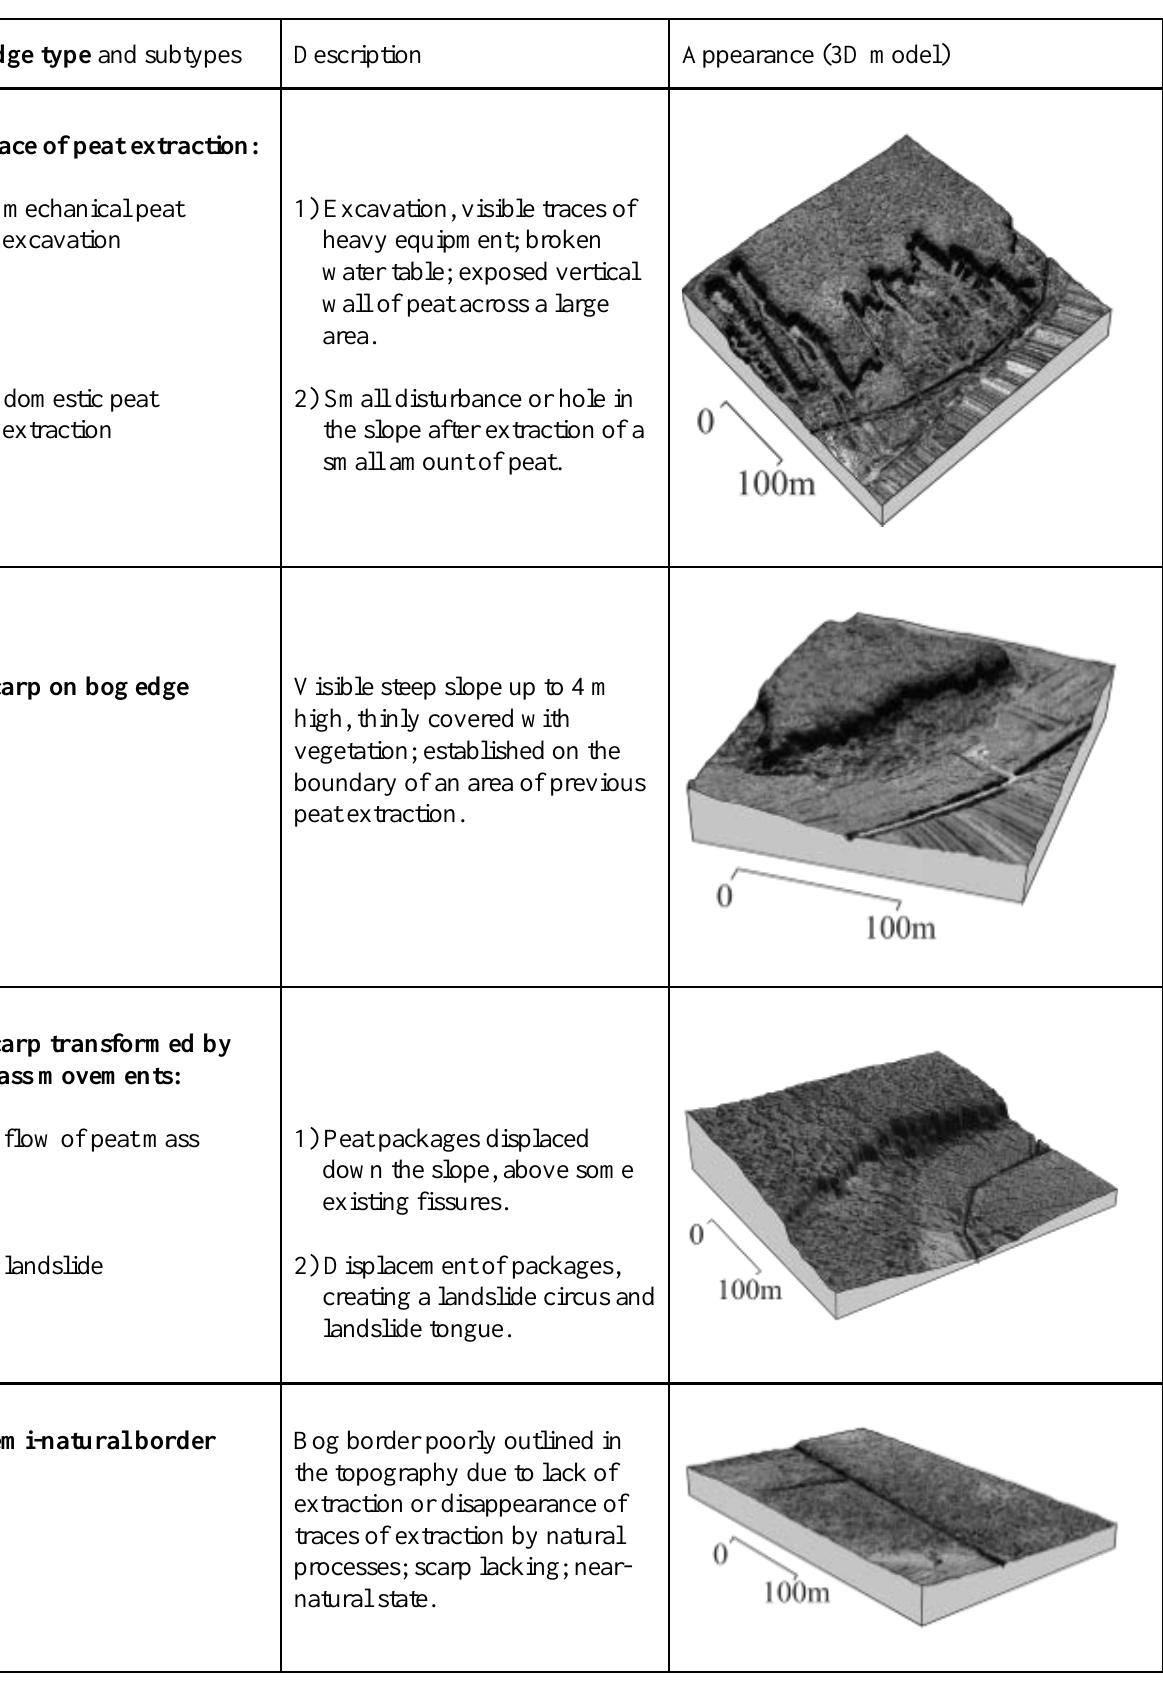
Table 1. Edge t ypology of the Ludźmierz bog. The linear depressions visible in the terrain model are parts of a system of drainage ditches around the